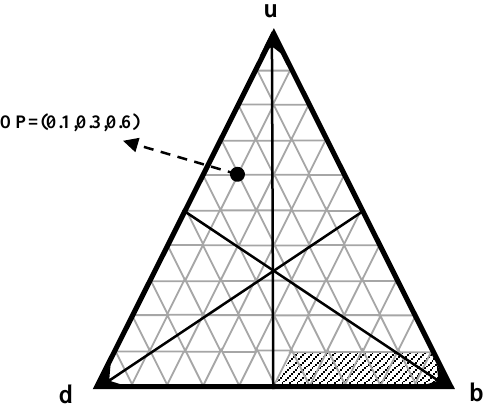
Figure. 1. Opinion triangle for an activity, namely 𝒂 . Point OP shows an opinion with 𝒃 𝒂𝑺 = 𝟎. 𝟏,𝒅 𝒂𝑺 = 𝟎. 𝟑 , and 𝒖 𝒂𝑺 = 𝟎.𝟔 , where 𝒔 is an opinion-owner. The dashed area shows an accept area for activity 𝐚